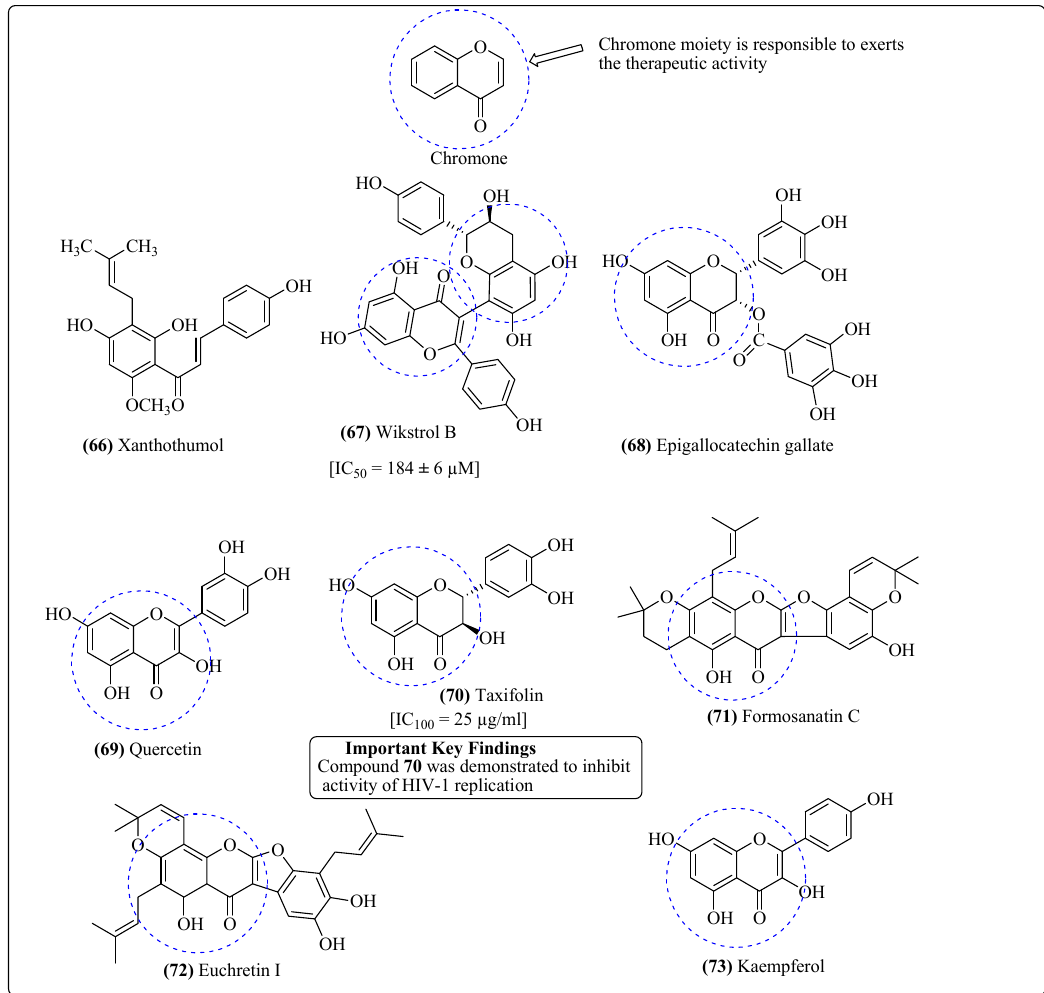
Figure 14. Flavanoids with anti-HIV properties.